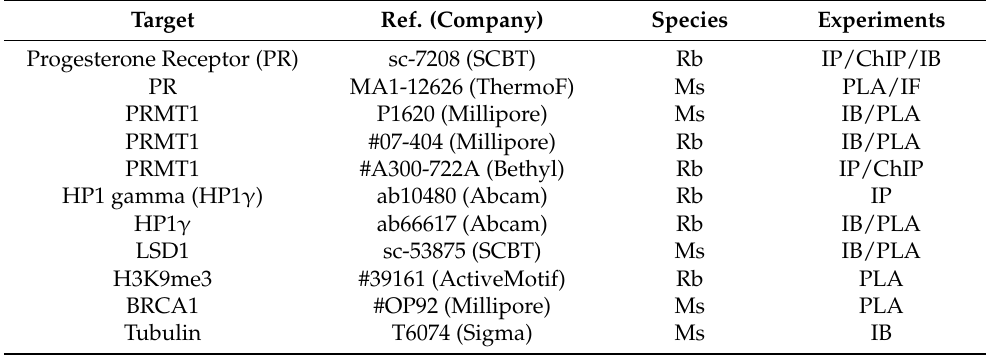
Table 1. List of antibodies used in this study. Rb: rabbit; Ms: mouse; IP: immunoprecipitation;